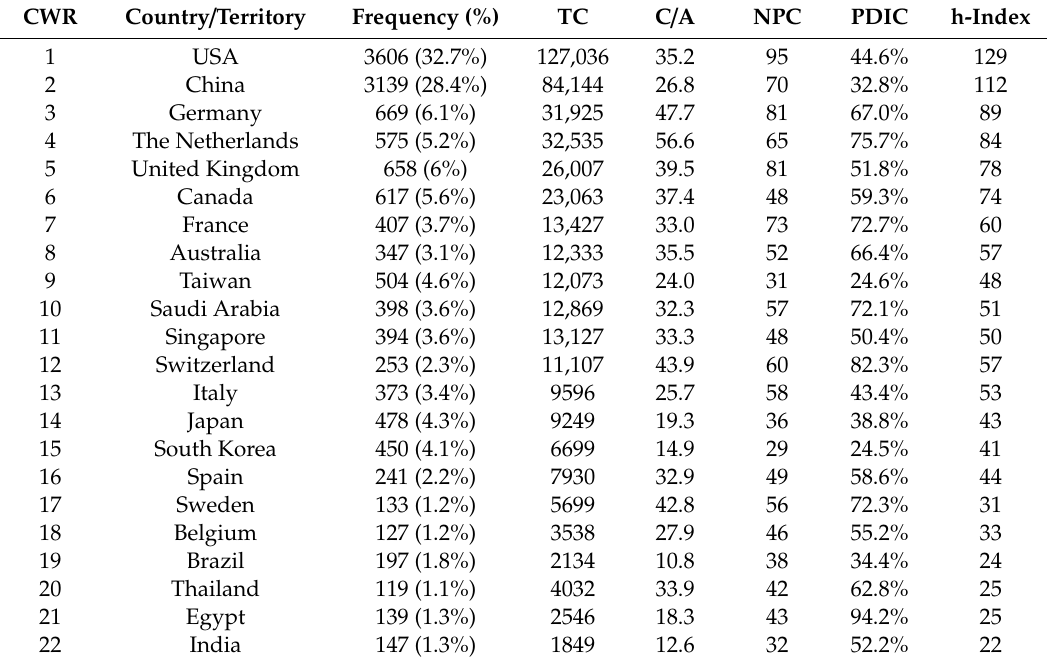
Table 3. List of countries / territories with a minimum contribution of 100 documents.